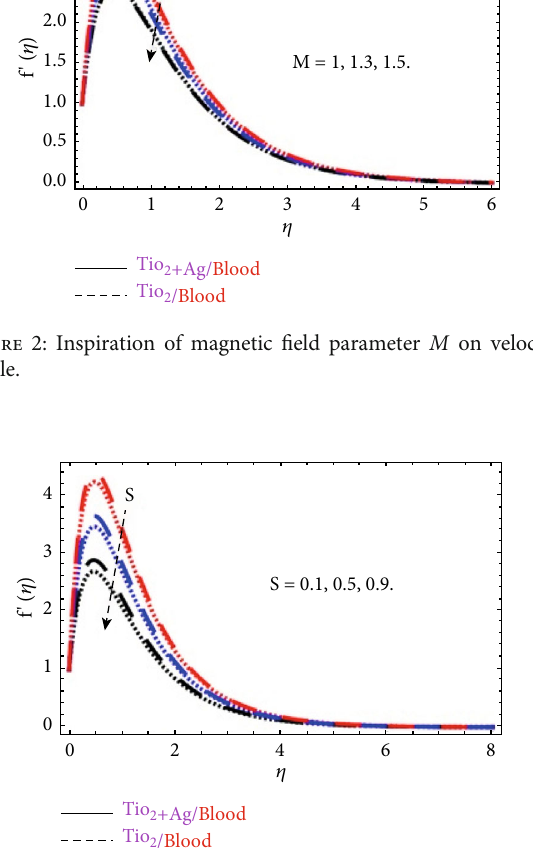
Figure 3: Inspiration of unsteady parameter S on velocity pro fi le.